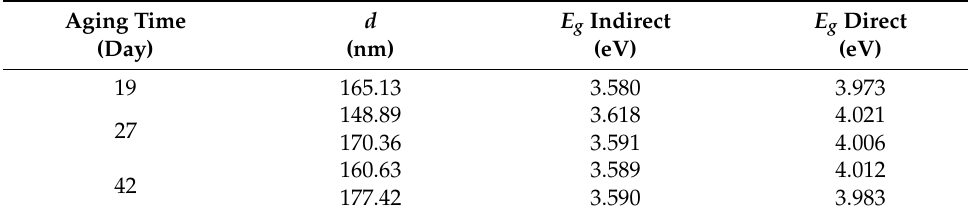
Table 2. Influence of sol aging time on optical band